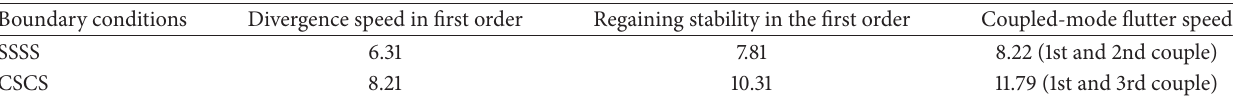
Table 2: Critical moving speed of axially moving plates with different boundary conditions.